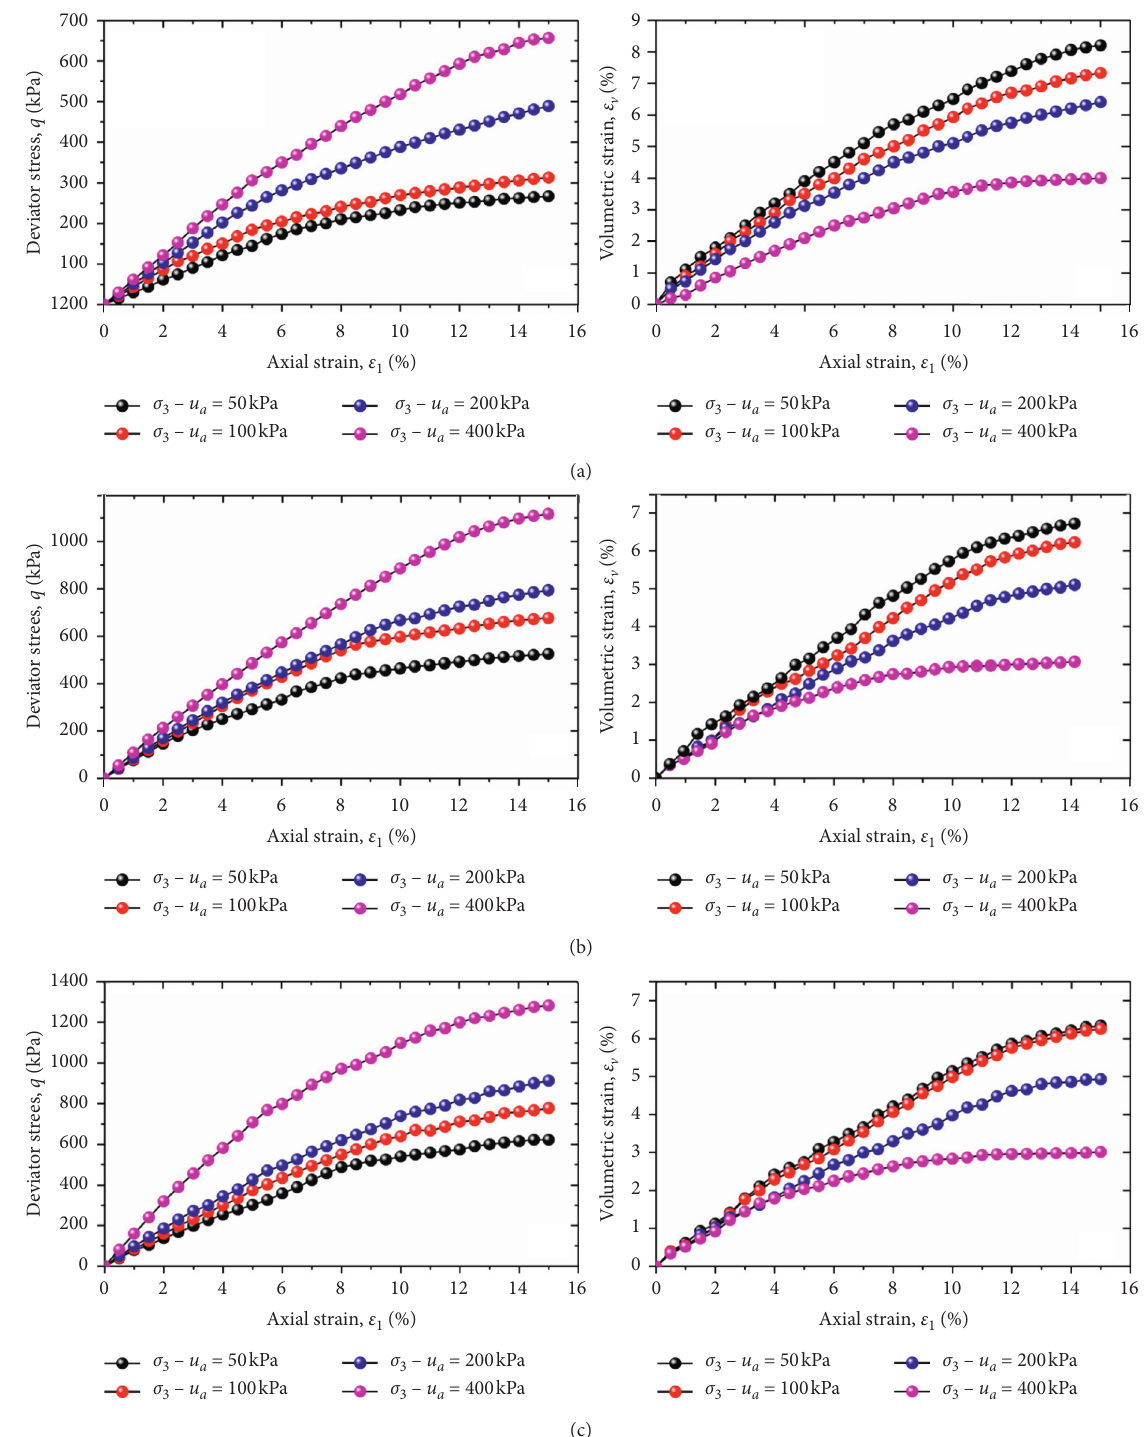
Figure 9: Effects of filling material content on the stress-axial strain and volumetric strain-axial strain curves for various controlled net confining pressures: (a) undisturbed sample, (b) grouting sample (3% nanosilica), and (c) grouting sample (5%